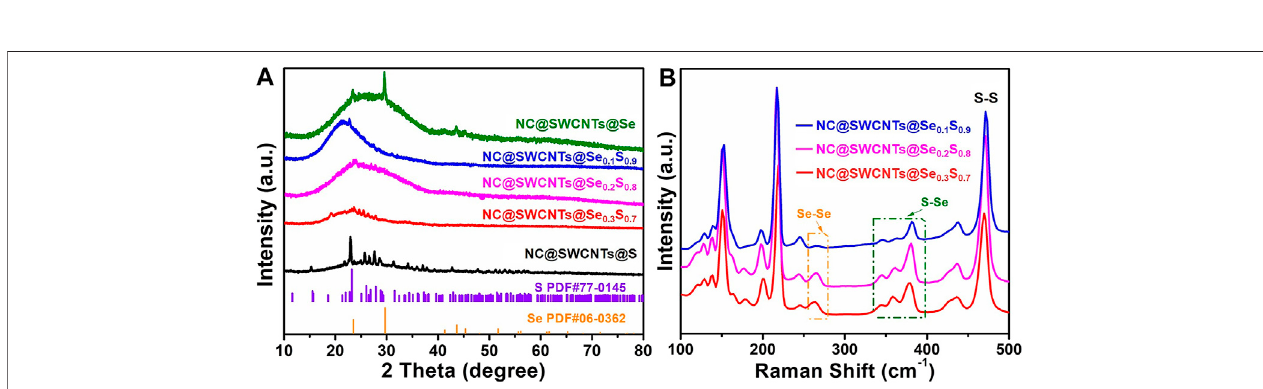
FIGURE 3 | (A) XRD patterns of NC@SWCNTs@S, NC@SWCNTs@Se 0.3 S 0.7 , NC@SWCNTs@Se 0.2 S 0.8 , NC@SWCNTs@Se 0.1 S 0.9 and NC@SWCNTs@Se. (B) Raman spectra of NC@SWCNTs@Se 0.3 S 0.7 , NC@SWCNTs@Se 0,2 S 0.8 and NC@SWCNTs@Se 0.1 S 0.9 .